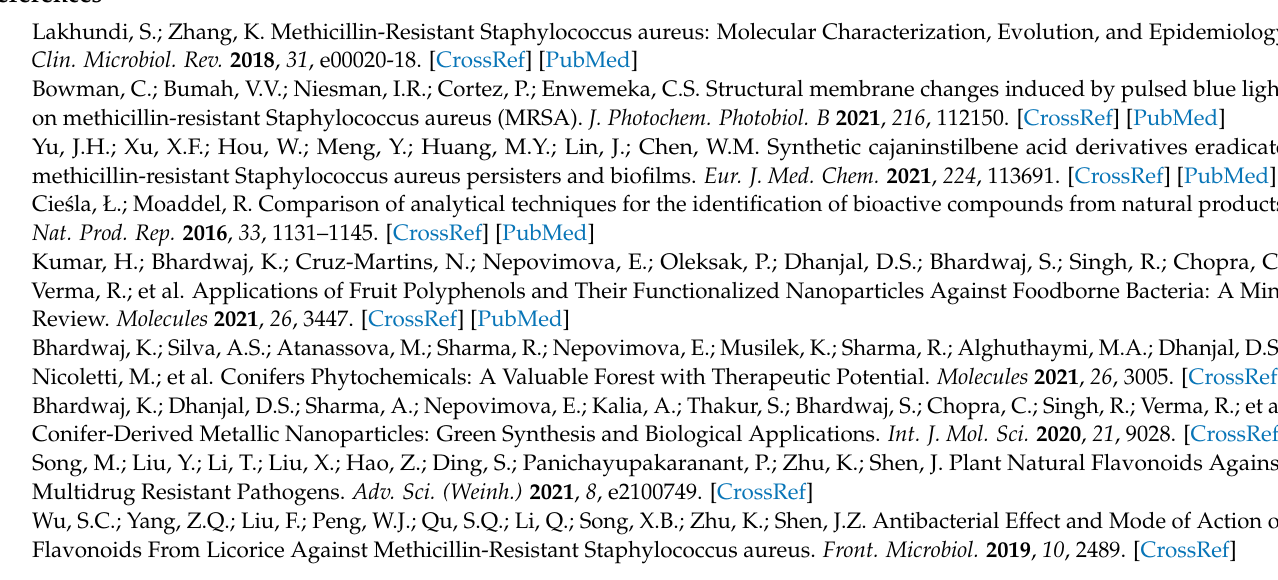
Figure S2: Separation process of Fr. A–D and compounds 1 – 8 from